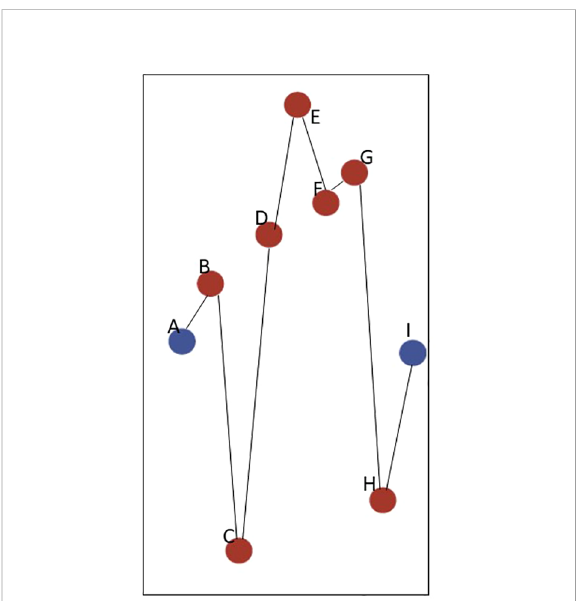
FIGURE 1 Schematic of Step Count Variability Measure Using a Participant ’ s Data. Here is an example of a subset of 4-hour blocks (blue indicates dialysis block, and red indicates non-dialysis block) between two consecutive dialysis sessions for one participant. Step count differences between each 4-hour block were calculated for each participant. Then, the step count variability was calculated as the standard deviation of the series of step count differences for each